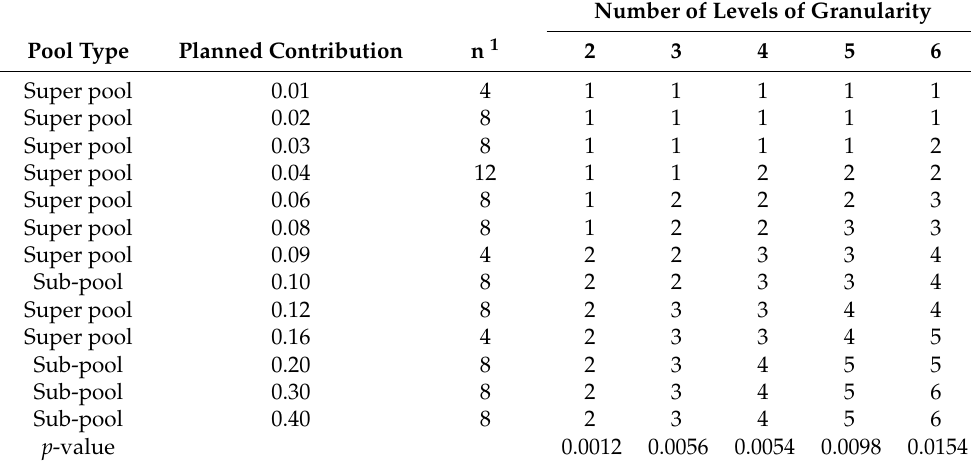
Table 2. Testing equality of variance for pool construction error; granularity of